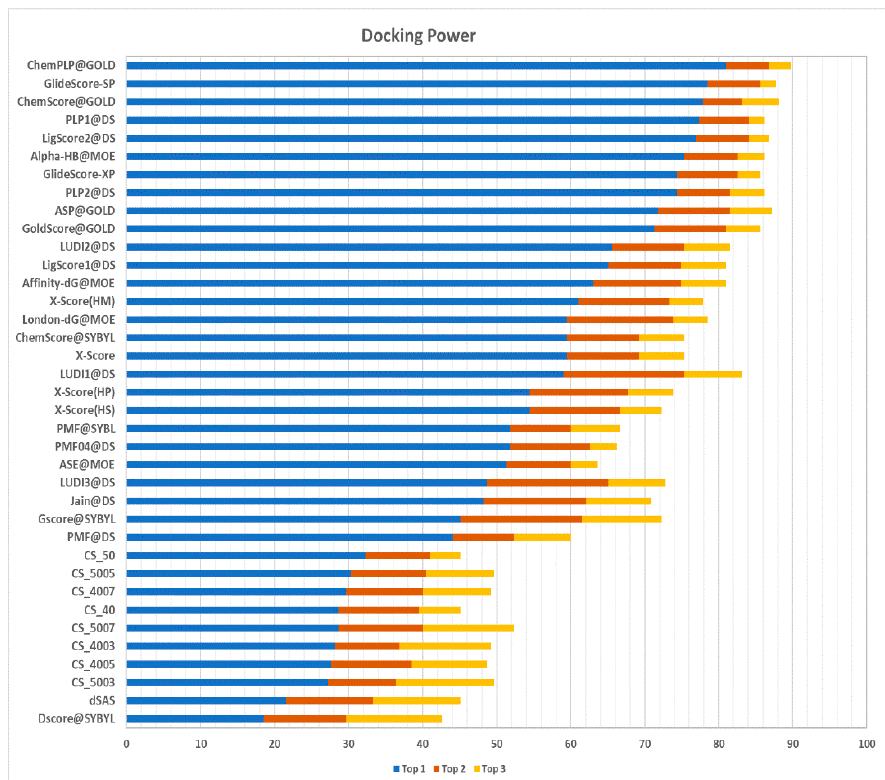
Figure 5. Comparison of the results of the CASF-2013 scoring functions and those based on the CS datasets in the docking power test ordered based on the presence of a native-like pose in the top one (blue bar), top two (orange bars), and top three (yellow bars) prediction(s).